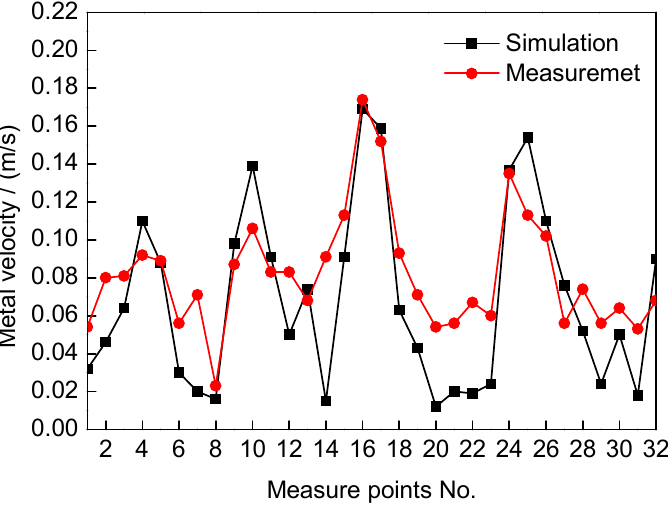
Figure 6. Metal velocity comparison between simulation and measurement (m/s).